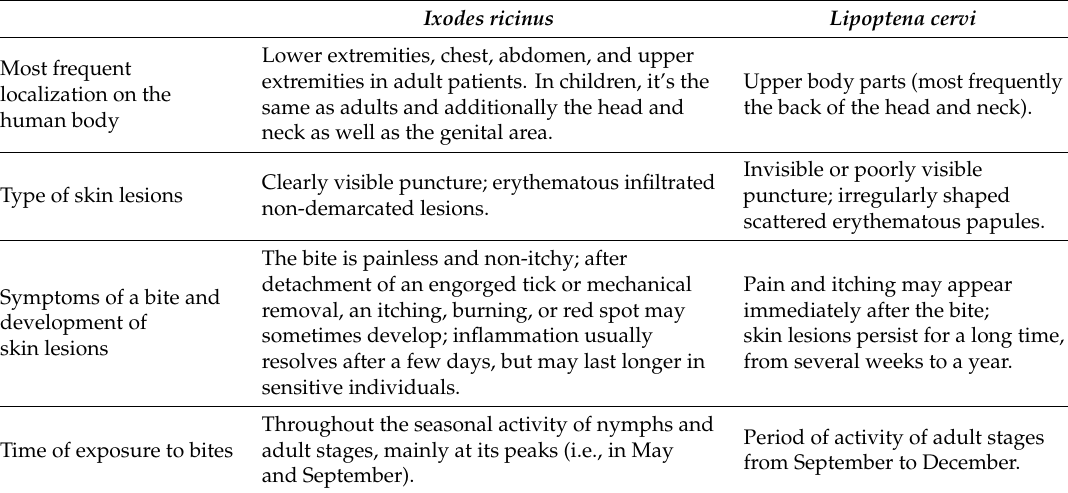
Figure 2. Scattered papules on an erythematous, irregular base after feeding of deer ked Lipoptena cervi , four weeks after the bite. Table 1. Di ff erences between skin lesions caused by bites of Ixodes ricinus and Lipoptena cervi